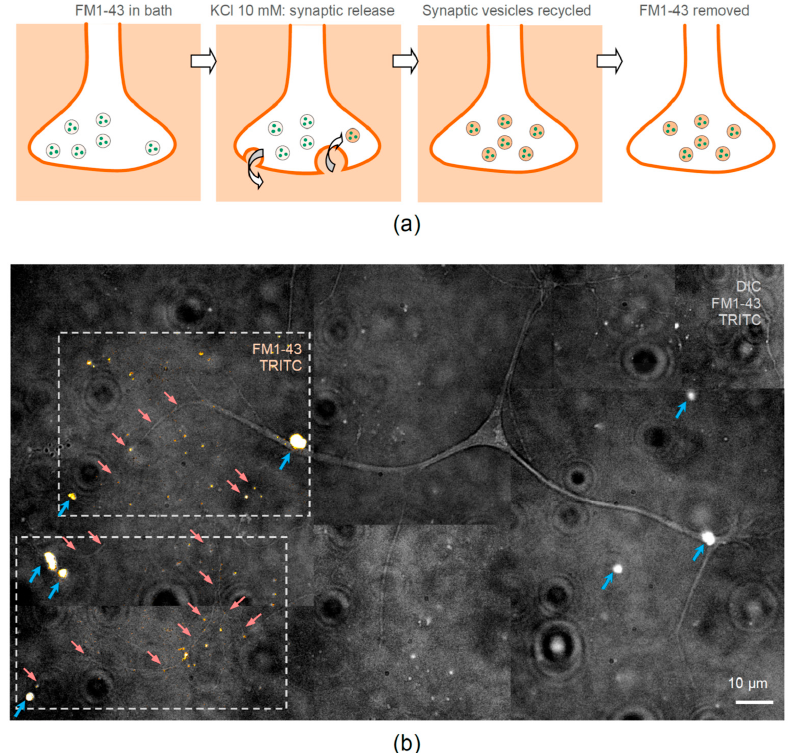
Figure 5. Neurites of hippocampal neurons are guided towards encapsulated NGF and form functional synapses. ( a ) A diagram sequence explaining fluorescence imaging of functional synaptic connections in cultured neurons using the fluorescent styryl dye FM1-43. The dye is washed in the bath, the active release of synaptic vesicles is activated by 50 mM KCl (bath application for 1 min), the recycled vesicles take up and store the dye inside the axonal terminal, and the external FM1-43 fraction is washed out leaving de- tectable fluorescence inside active synapses. ( b ) One neuron example in neuron-astrocyte co-culture, with neuronal main and smaller processes growing towards clusters of NGF- releasing LbL-microcapsules at 7 days in vitro. Grey-scale image, merged DIC, TRITC, and FM1-43 fluorescence; red arrows, examples of neurites growing towards clusters of LbL-microcapsules (blue arrows, TRITC labelling); dotted frames, two ROIs illustrating fluorescence of TRITC and FM1-43 fused with DIC image to highlight the FM1-43 labelled functional synapses (orange spots) revealed after KCl